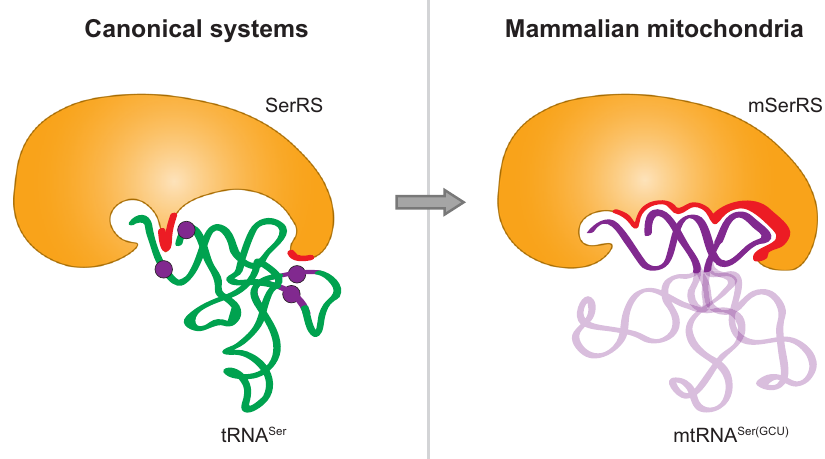
Fig. 6 | Divergence and rewiring of tRNA Ser identity rules in animal mitochon- drial gene expression. In the ancestral canonical serylation systems (left), SerRS relies on discrete sequence identity elements (purple) inserted into the universal structuralscaffoldofthecanonicaltRNA.Inthederivedmammalianmitochondrial